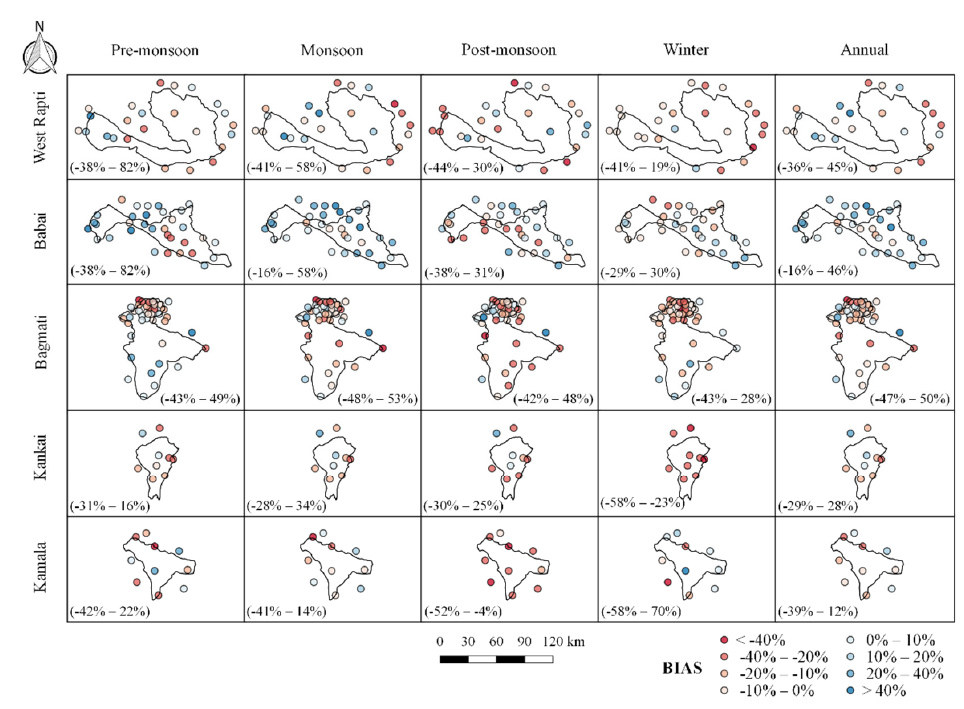
Figure 5. Spatial distributions of RMS between the CHIRPS product and rain gauge observation at the seasonal and annual scales.